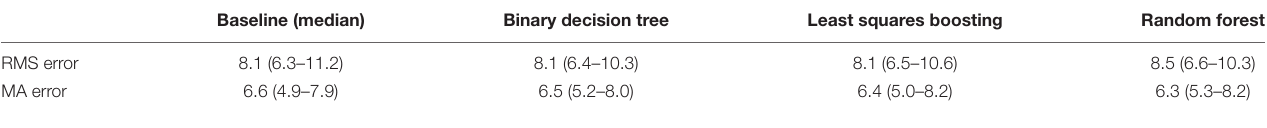
TABLE 1 | Medians and interquartile ranges of root-mean-square (RMS) and mean absolute (MA) errors for the baseline estimator (median of other 14 intervals) and for three machine learning methods in dyad-specific engagement estimation. Baseline (median) Binary decision tree Least squares boosting Random forest RMS